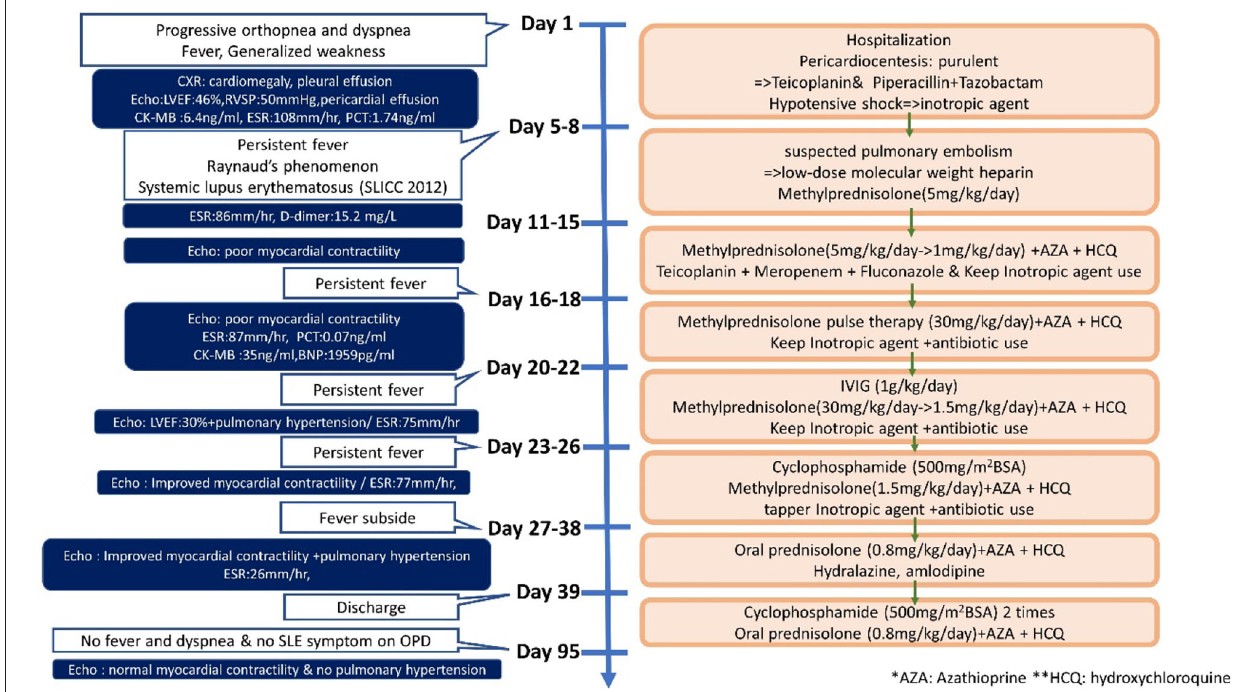
FIGURE 1 | Timeline of this case